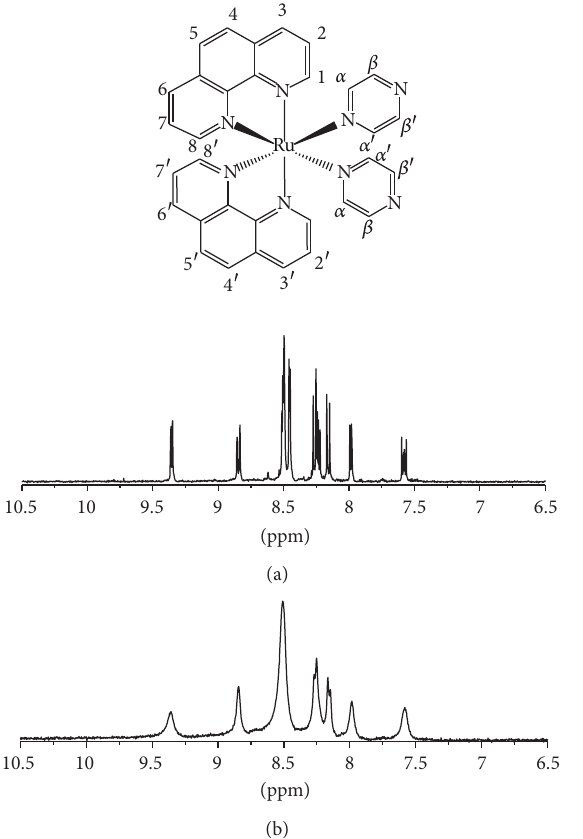
H NMR spectra in CD complex II (a) and complex I (b). 1